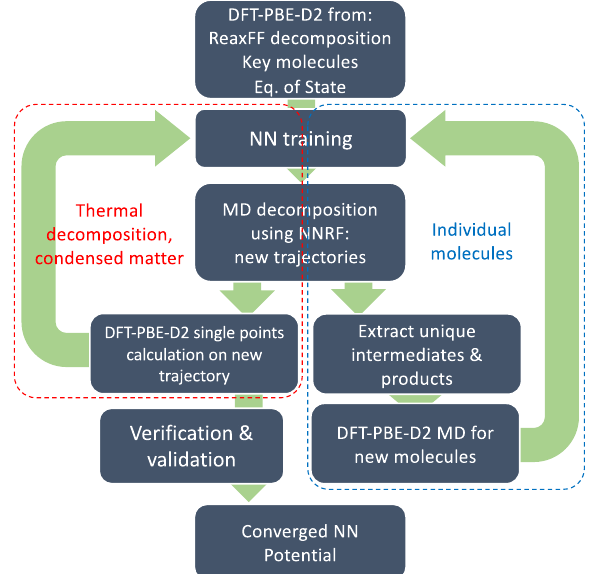
Fig. 1 A schematic diagram of the iterative NNRF development process. Two different feedback loops enhance the training set: automatic generation of con fi gurations during decomposition and reaction (left red box) and extraction of chemical species and intermediates (right blue box). The list of entries and their numbers are all tabulated in Supplementary Table simulation samples the original crystal, the initiation of chemistry, and the formation of intermediates as well as fi nal products. We extracted 4000 frames (one every 0.1 ps) from the ReaxFF trajectory and performed single point density functional theory (DFT) calculations using Perdew – Burke – Ernzerhof (PBE) exchange- correlation functional 33 and the empirical D2 correction for